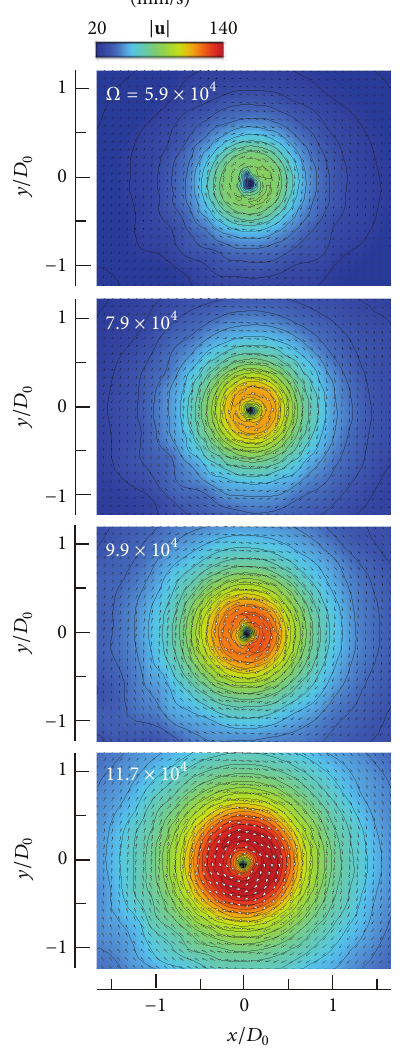
Figure 4: Velocity of swirling water flow over horizontal section at = 4.17 ( 𝑄 = 0 ). 𝑧/𝐷 0 𝑔